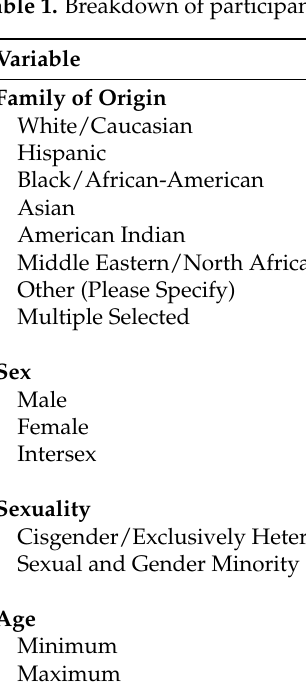
Table 1. Breakdown of participant